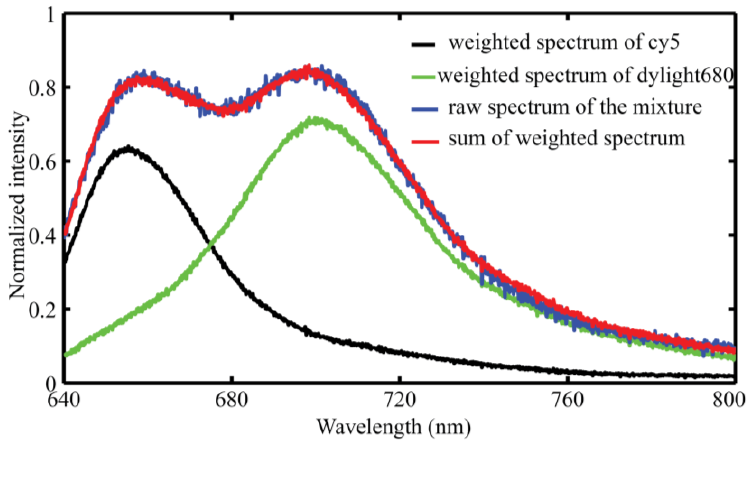
Figure 6. Multivariate analysis of mixed solution containing two spectrally overlapping